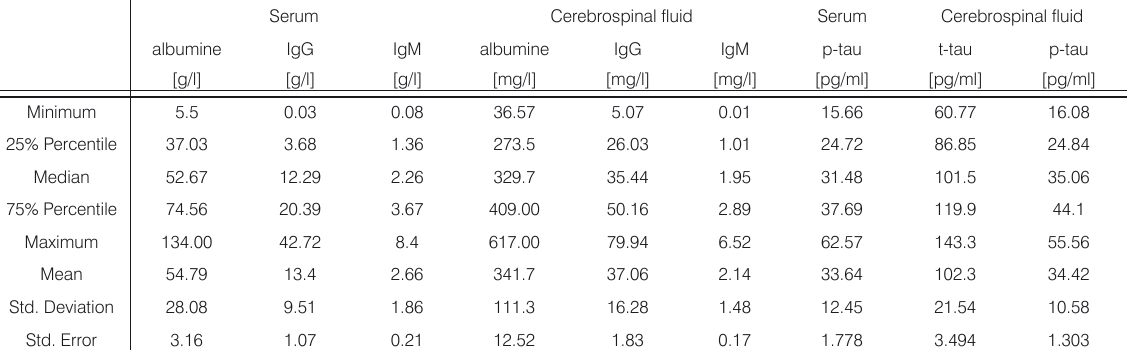
Table 2. Summarized CSF and serum results in patients with MS.